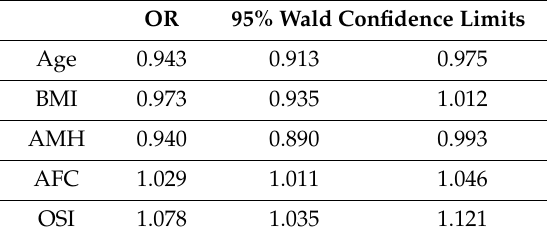
Table 4. Multivariable analysis of the variables associated with clinical pregnancy (CPR / ET). The results are presented with an odds ratio (OR) and 95% confidence interval (95% CI)